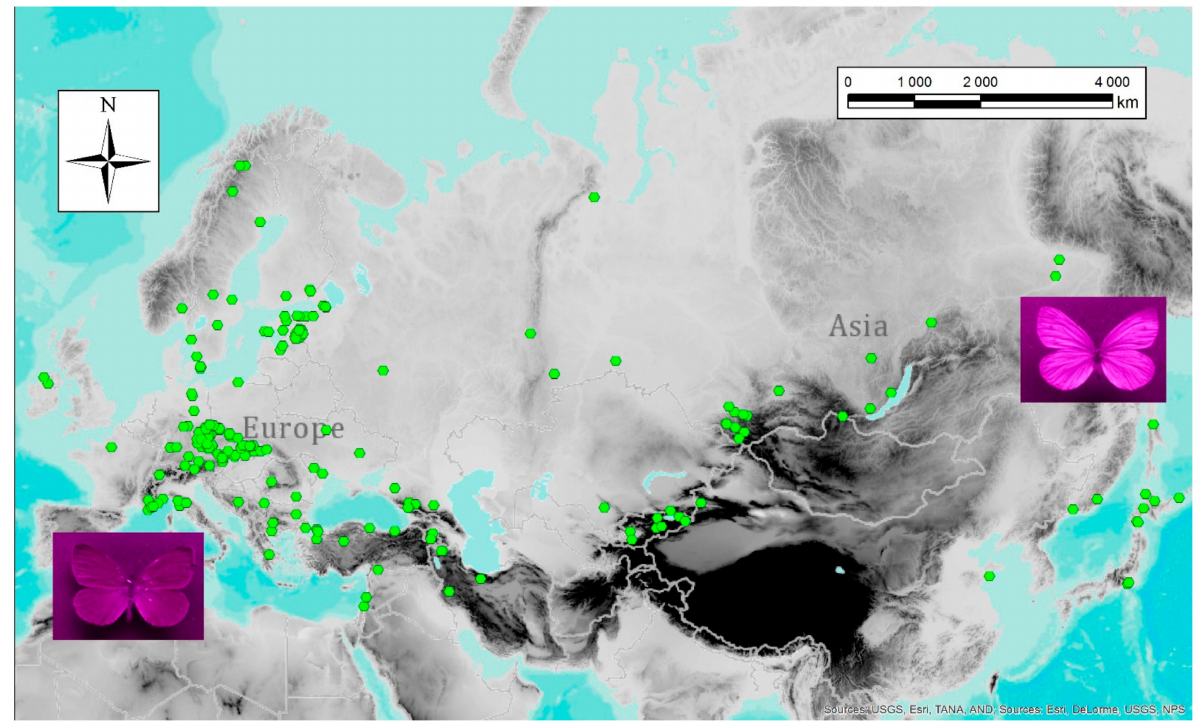
Figure 2. Locations of the 407 specimens of the green-veined white ( Pieris napi ) from the Palaearctic region from [61]. Female Pieris napi generally exhibit a less intense UV reflectance in western and southern regions of the